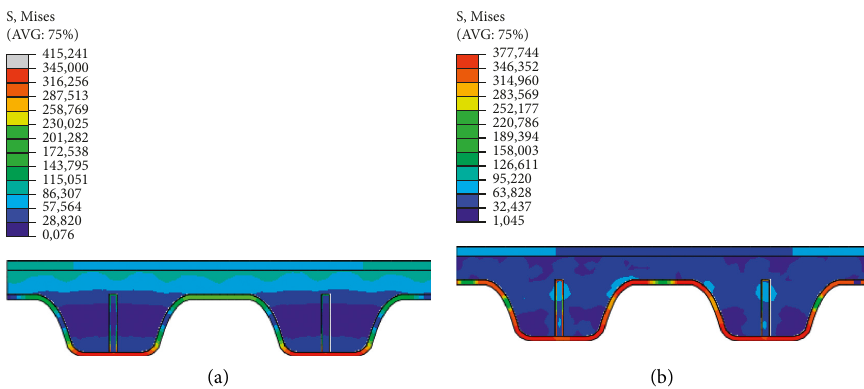
Figure 16: Stress in the cross section of the steel plate. (a) Under 70% of the ultimate load. (b) Under the ultimate